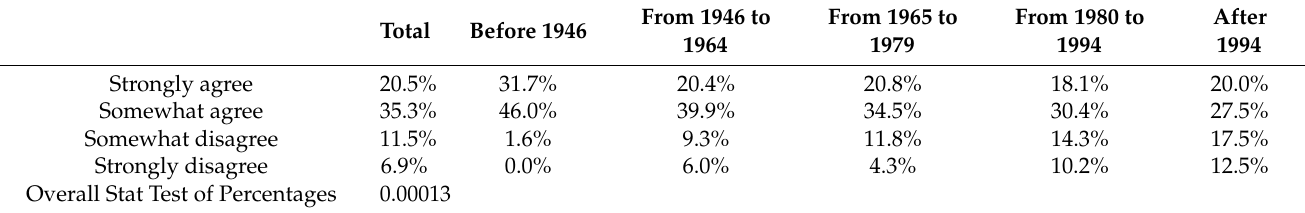
Table 6. I believe the dairy industry treats cows and other animals humanely in